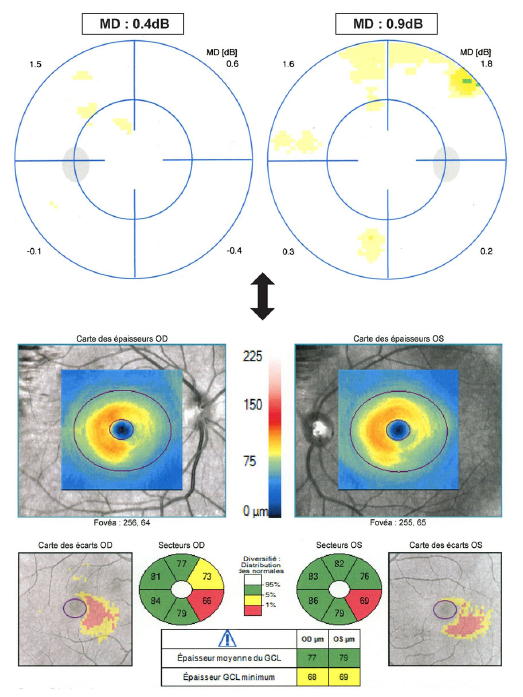
Figure 6: Detection of asymptomatic retrochiasmal damage by op- tical coherence tomography (OCT). Top – normal visual field of a patient with multiple sclerosis who was never visually sympto- matic. Bottom –OCT of the same patient, performed at the same date, demonstrated a homonymous left inferior thinning of the reti- nal ganglion cell layer, visible on the thickness maps, the deviation maps and the sector maps. MD = mean defect expressed in deci- bels